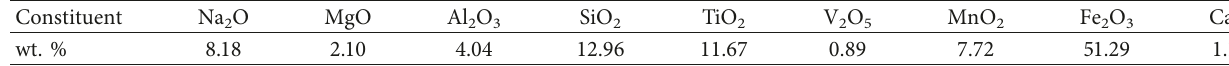
Table 1: Main chemical composition of vanadium and titanium slags.